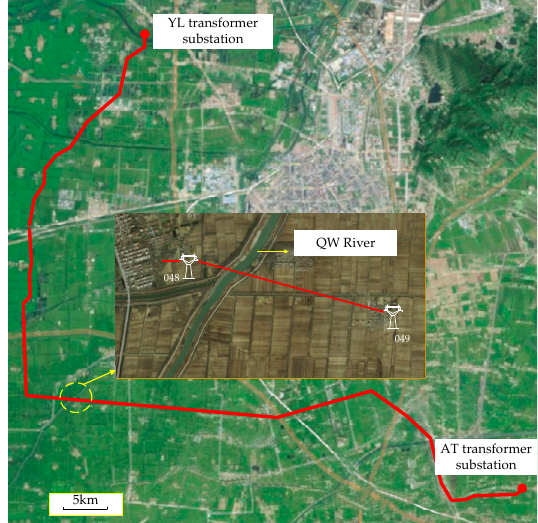
Figure 8. The distribution of the 500 kV transmission line.